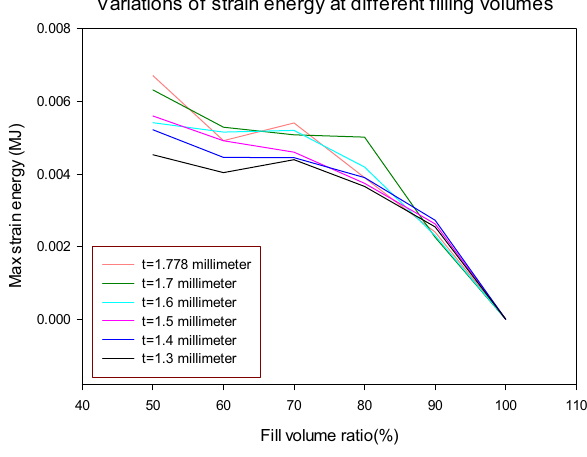
Fig. 24 The variation of strain energy at different filling levels at dif- ferent thicknesses of the diaphragm